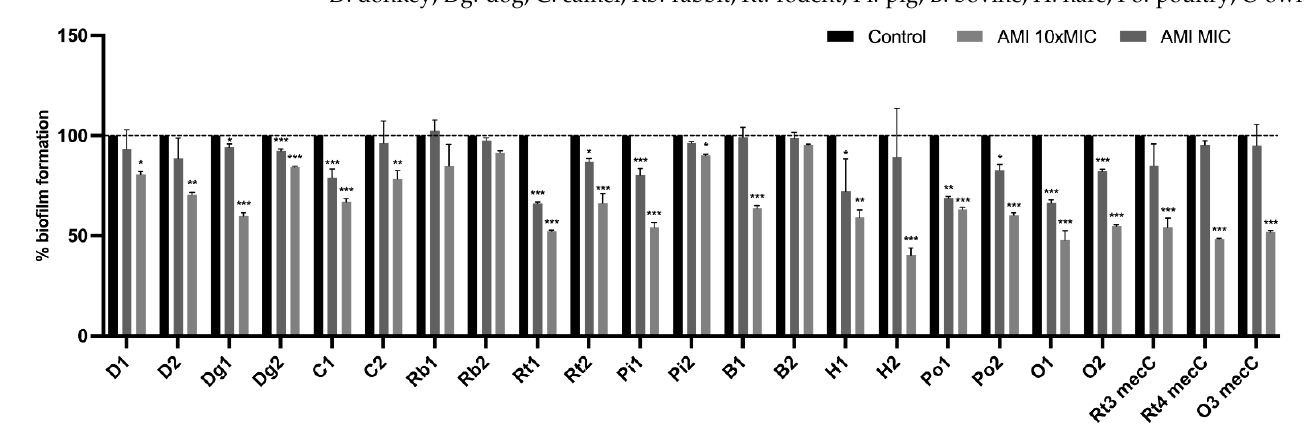
Figure 7. Effect of amikacin on the biofilm biomass reduction of 23 isolates at MIC and 10× MIC. Data are presented as mean ± standard deviation for four independent replicates. Statistical signifi- cance was determined using Dunnett ’ s multiple comparison test (* p < 0.05; ** p < 0.01; *** p < 0.001). D: donkey; Dg: dog; C: camel; Rb: rabbit; Rt: rodent; Pi: pig; B: bovine; H: hare; Po: poultry; O owl.